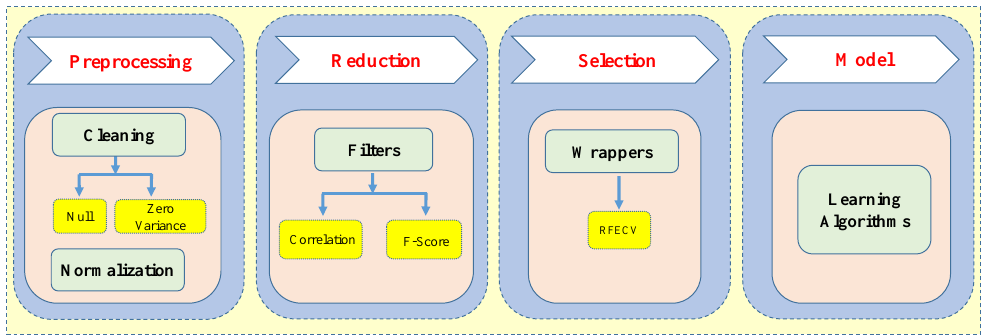
Figure 3. Illustration of the phases to develop final descriptors